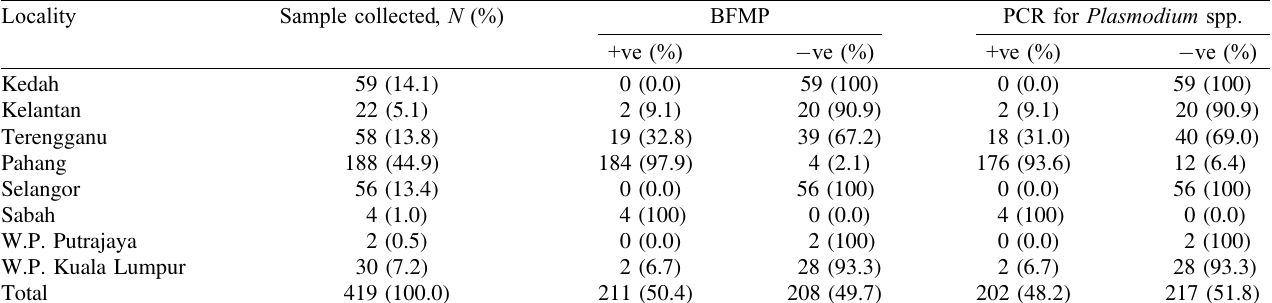
Table 1. Plasmodium spp. detected by microscopy and PCR. Pahang, Kelantan and Terengganu have been classi fi ed as high endemic areas for P. knowlesi infection. Meanwhile, Kedah, Selangor, Putrajaya, and Kuala Lumpur have been described as low-endemic areas despite co- existing macaques and the human population.